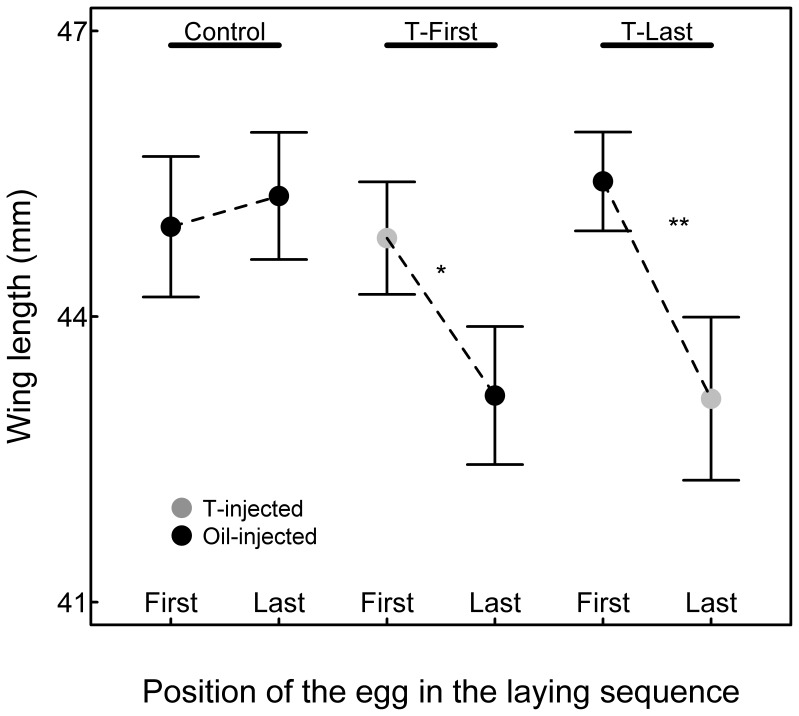
Wing length (mean ± SE) of chicks in relation to the laying position and treatments.Grey points indicate chicks hatched from T-injected eggs. Black points indicate chicks hatched from oil-injected eggs.